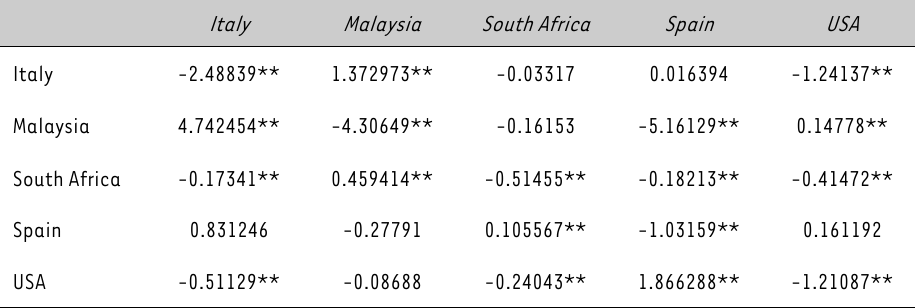
TABLE 12: Uncompensated own-price and cross-price elasticities for UK tourists